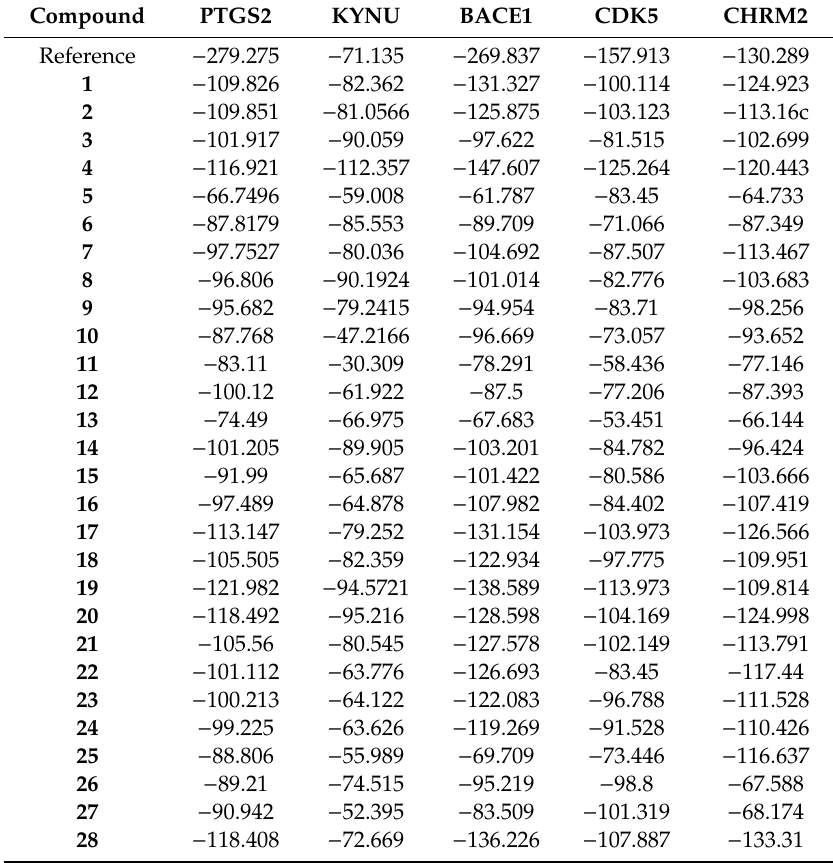
Table 4. Results of molecular docking studies of compounds 1 – 28 in the active sites of proteins (PDB ID 5F19, 2HZP, 3UQU, 3O0G, and 3UON) performed using Molegro Virtual Docker (MVD).